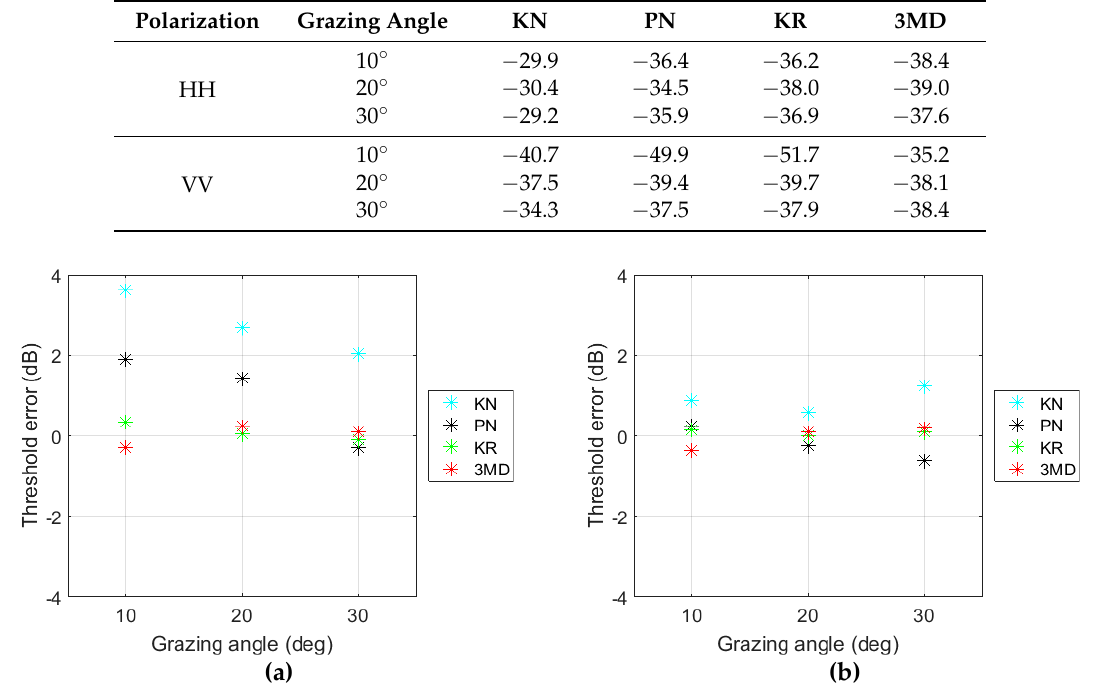
Figure 19. Threshold error with increasing grazing angle for SETHI X-band Runs 3 to 5 (wind speed 7 m/s). Threshold error is measured at a CCDF of 10 − 4 . ( a ) HH, ( b ) VV.